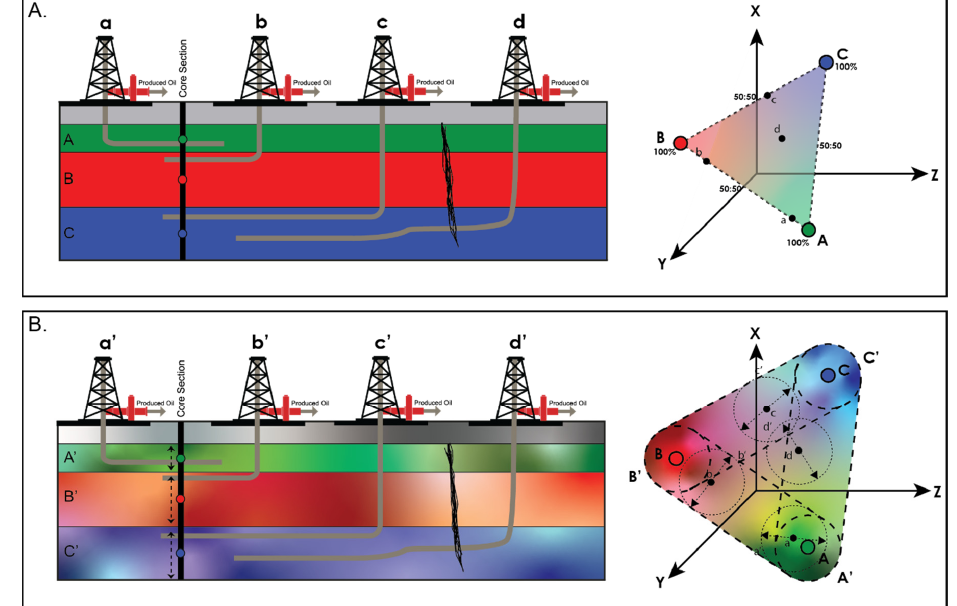
Figure 3. Schematic diagrams to illustrate the difference between a perfect ( A ) homogenous unconventional system and a natural ( B ) heterogeneous unconventional system. ( A ) This model includes 3 homogenous target zones for which end ‐ member fluids have been defined. The 4 wells producing from these zones can then be un ‐ mixed relative to the end ‐ members and contributions defined to a high degree of certainty. ( B ) This model includes 3 heterogeneous target zones and while apparent end ‐ member fluids can be defined there will always be a range of values and a cloud of uncertainty in which a fluid is producing entirely from a single zone. The uncertainty is defined from stratigraphic core, and, therefore, the additional lateral variation is also unaccounted for. All of the producing wells can be tied back to these apparent end ‐ members but again a significant cloud of uncertainty is the norm to account for the range of potential end ‐ member signatures.